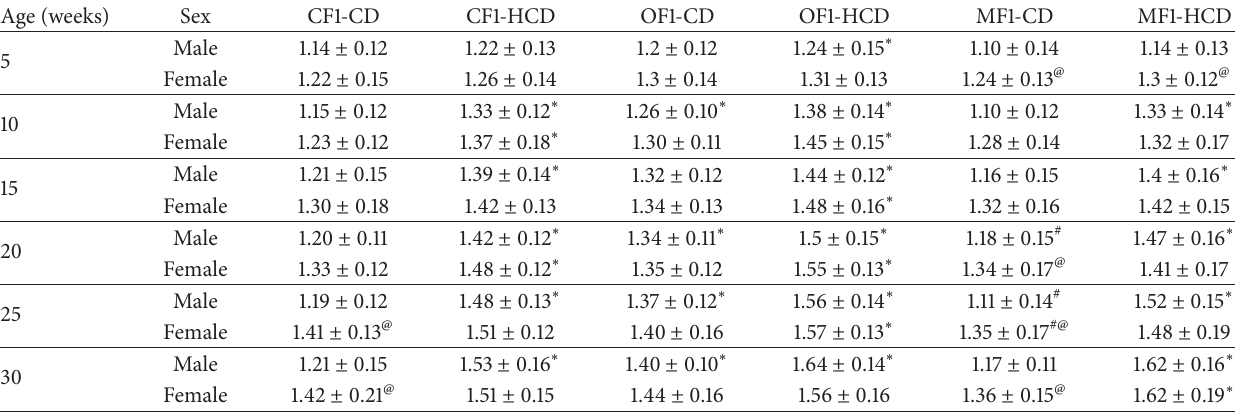
Table 2: Serum NEFA level (mmol/mL) in different study groups.